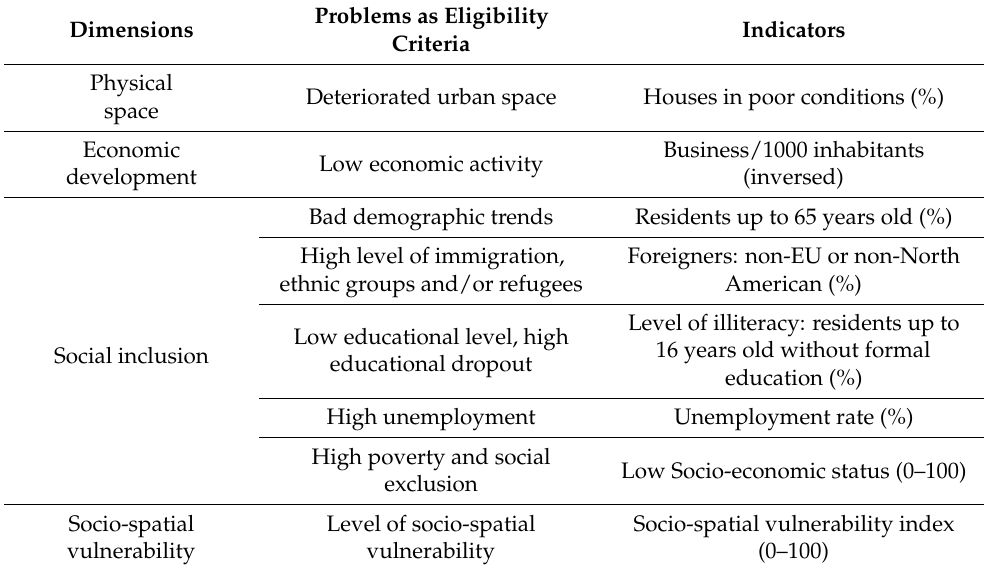
Table 3. Indicators of eligibility